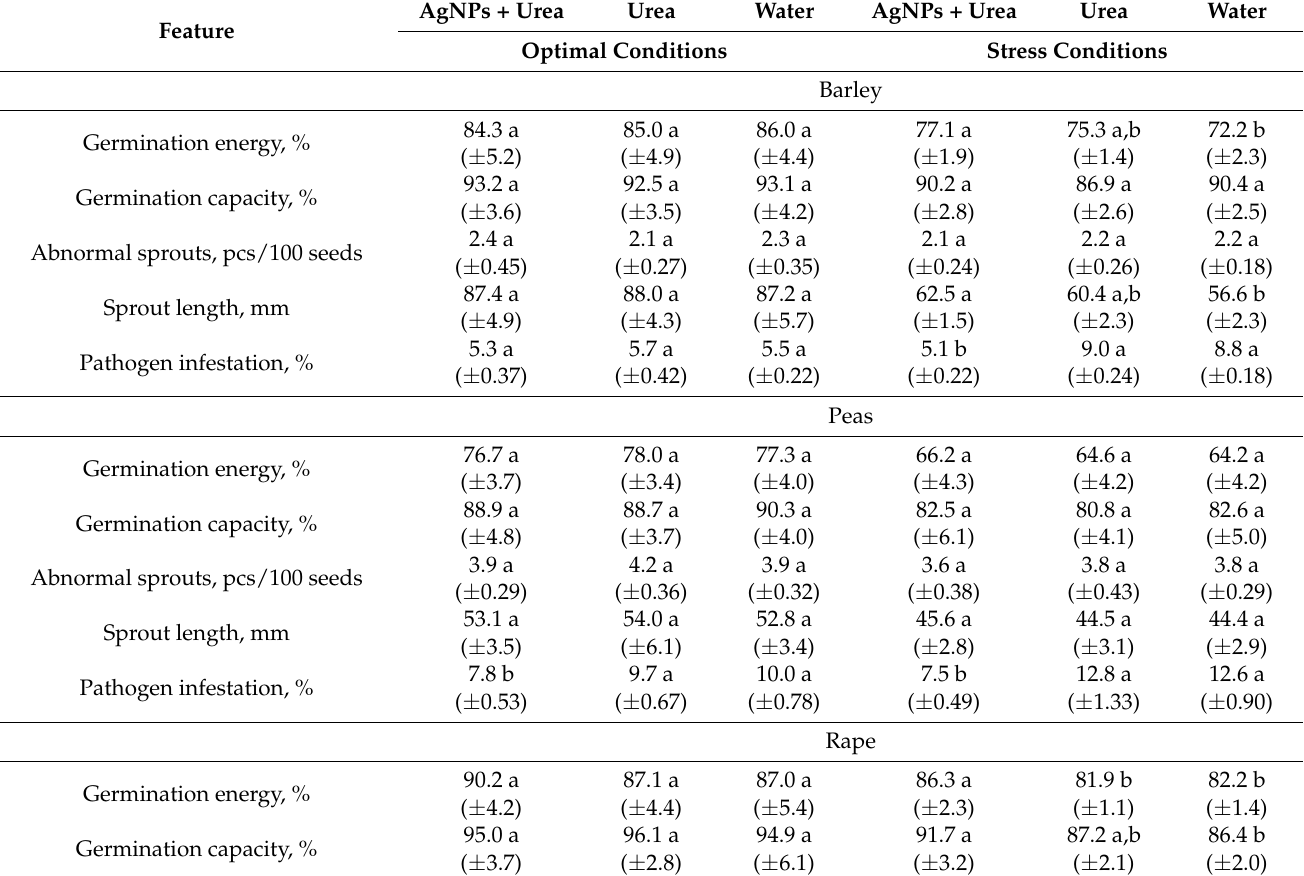
Table 3. Germination of crop seeds in the presence of AgNPs in the substrate; urea solution with AgNPs (AgNPs + Urea), urea solution (Urea), water (Water). a, b—letters in the rows for optimal